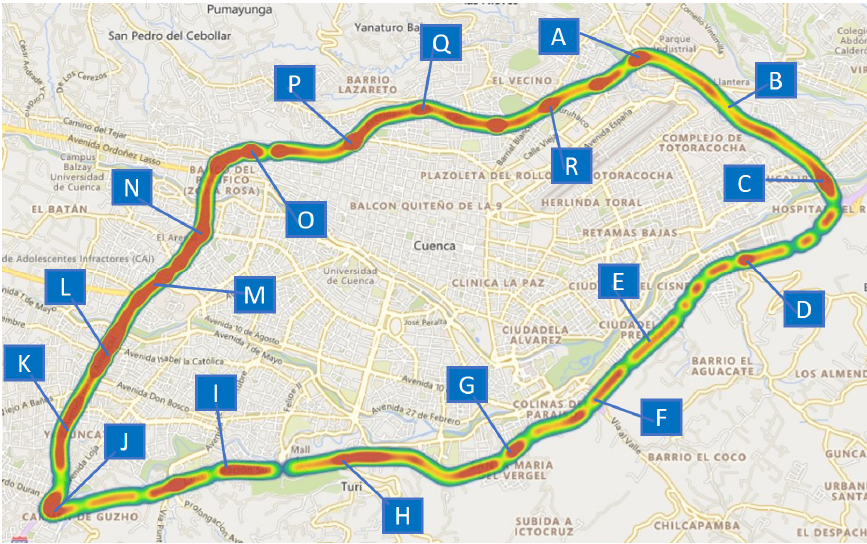
Figure 8. Map with selected points for analysis (A–R points explained in Table 3).